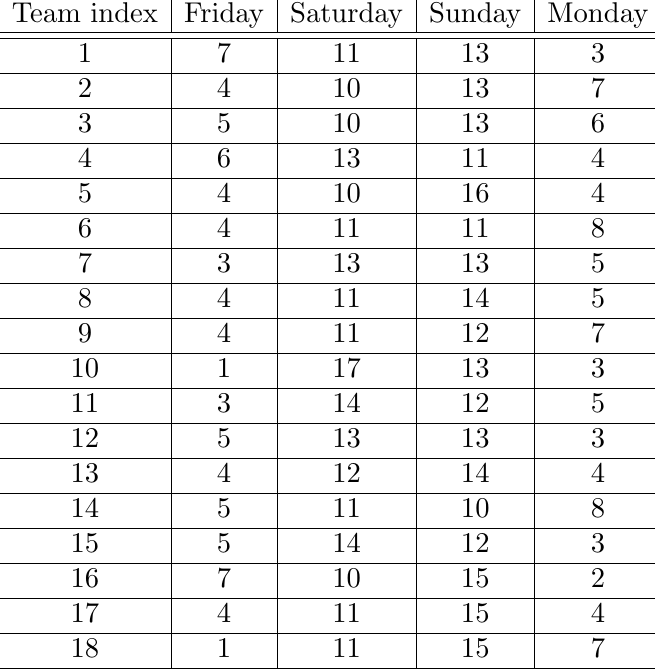
Table 5. Seasonal matchday distribution of games for each team obtained by the manual schedule.